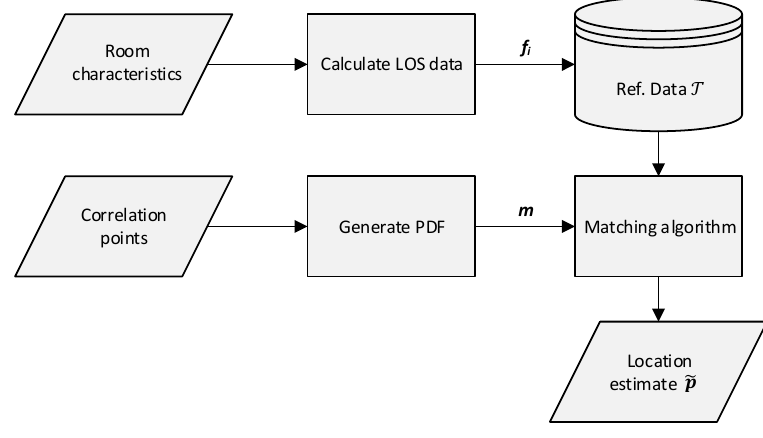
Figure 2. Flowchart of the PDF matching algorithm localization solution.